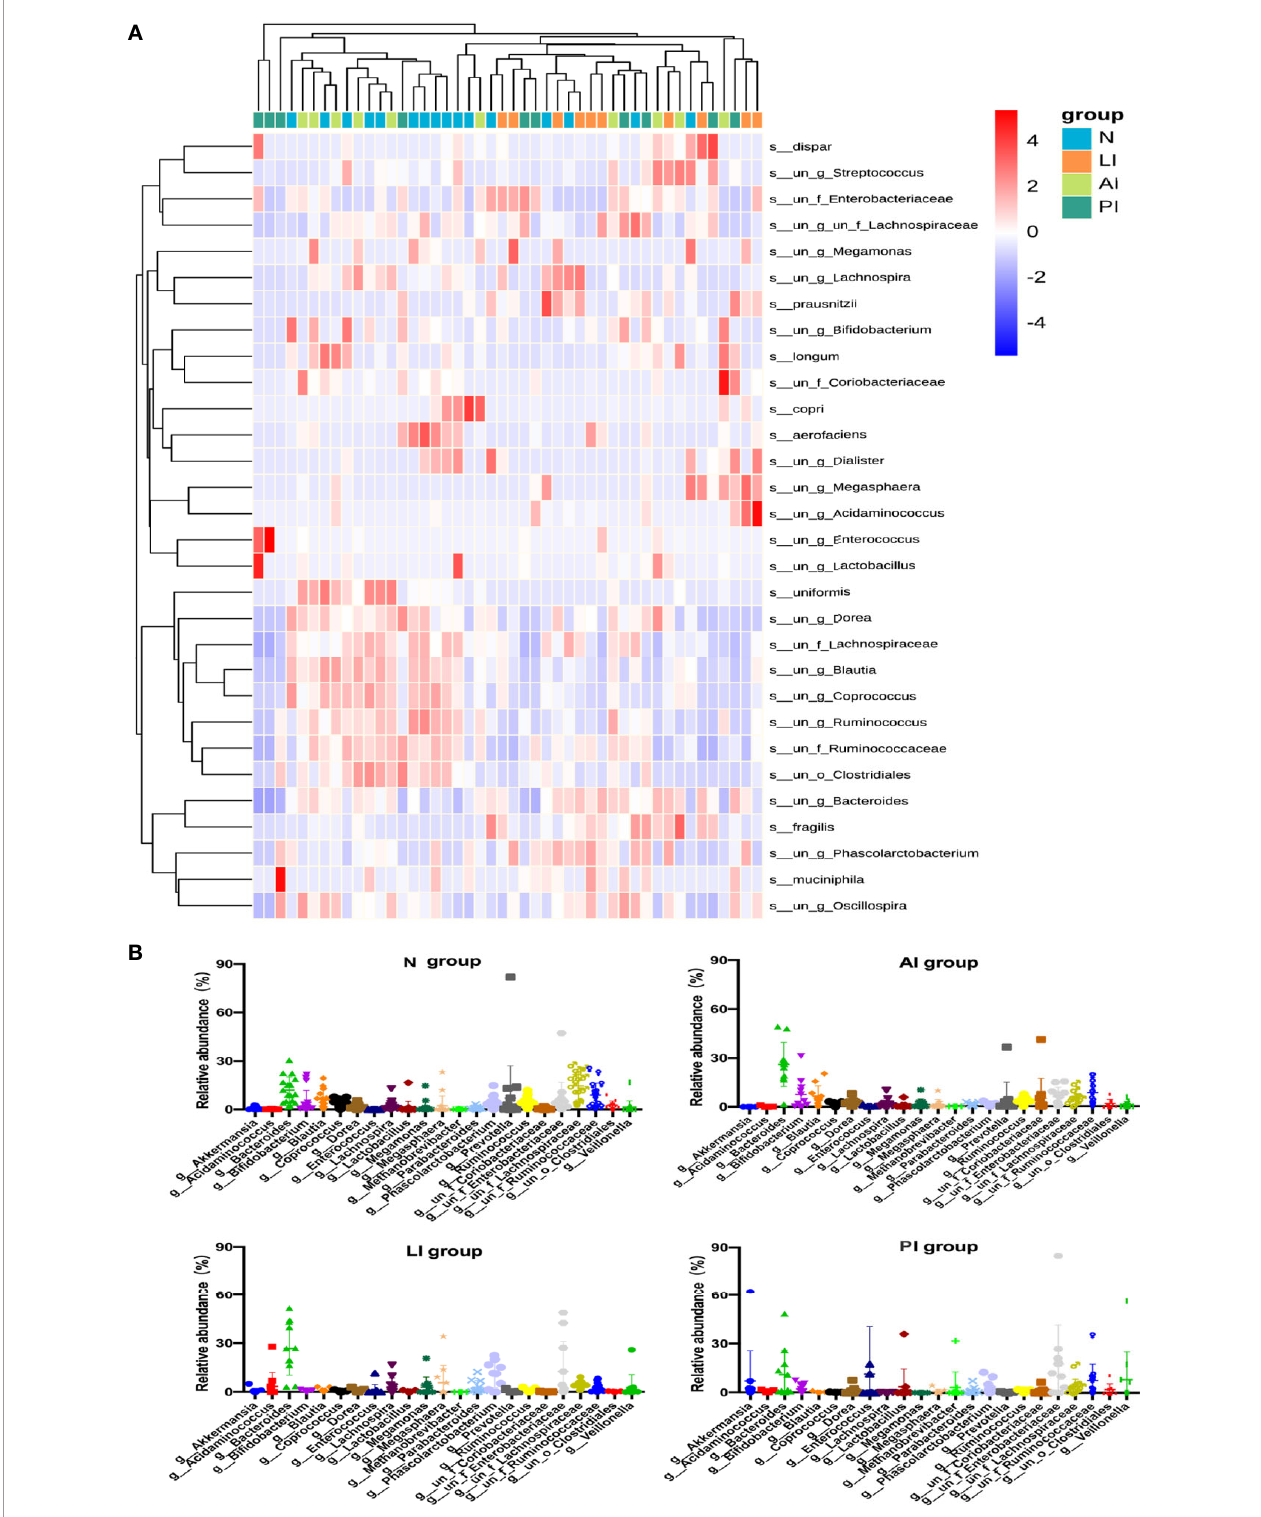
FIGURE 5 | (A) A heat map showing the relative total abundances of the top 30 species, and the relative abundances of all species, at the genus level. (B) A taxonomic summary of the gut microbiota of each group at the genus level. Starring (*) indicates a signi fi cant difference between two